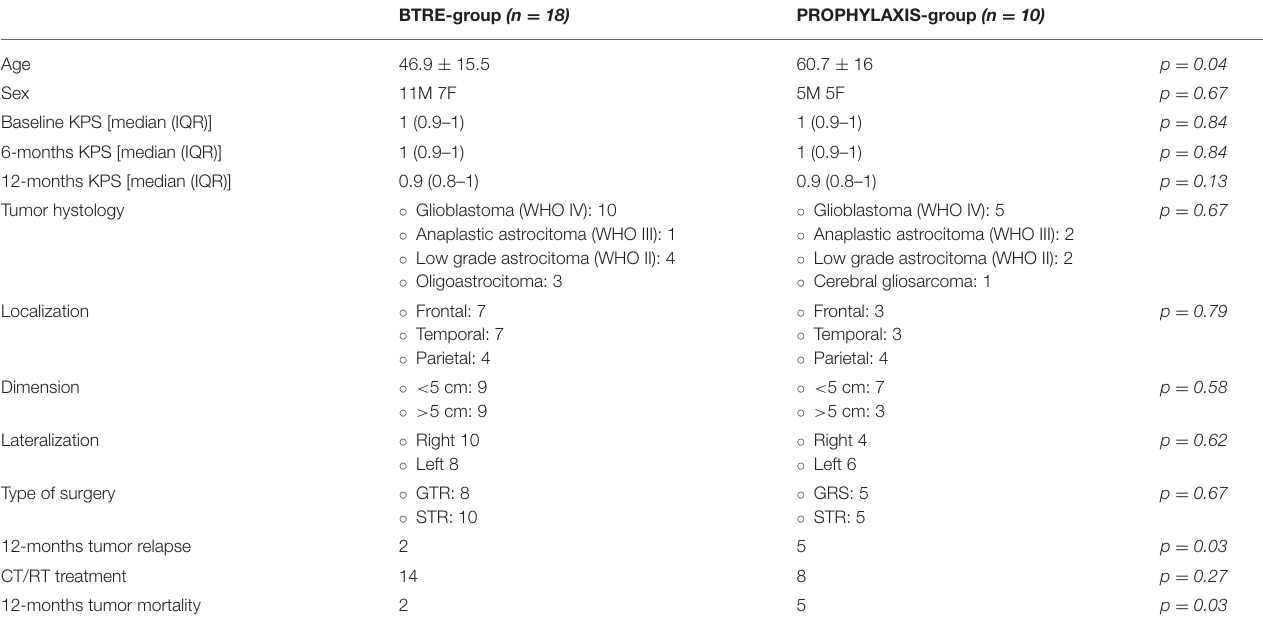
TABLE 1 | Demographics and brain tumor characteristics and